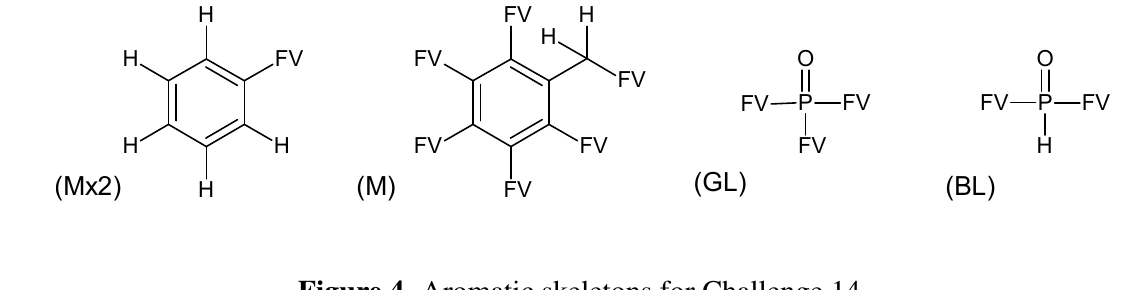
Figure 4. Aromatic skeletons for Challenge